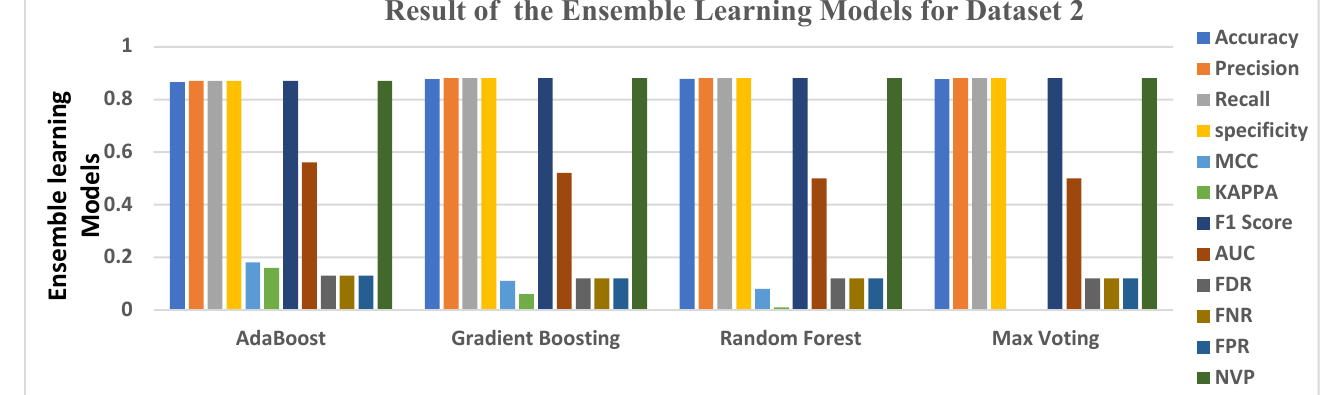
Figure 4. Graphical representation of Evaluation Metrics against Ensemble Learning Models for Dataset 2.